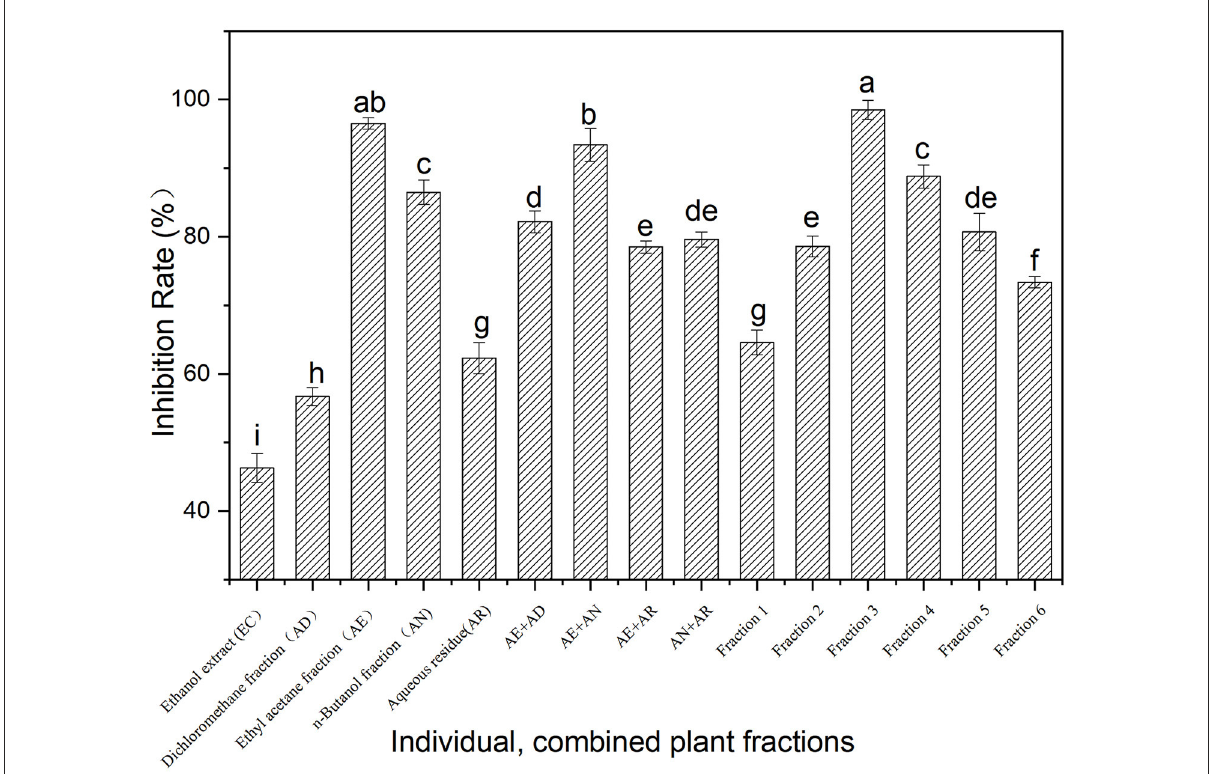
FIGURE1 Inhibition on α -glucosidase activity of the fractions from Fenghuang tea. The values with different small letters (a–i) indicate a significant difference between different groups at p < 0.05.